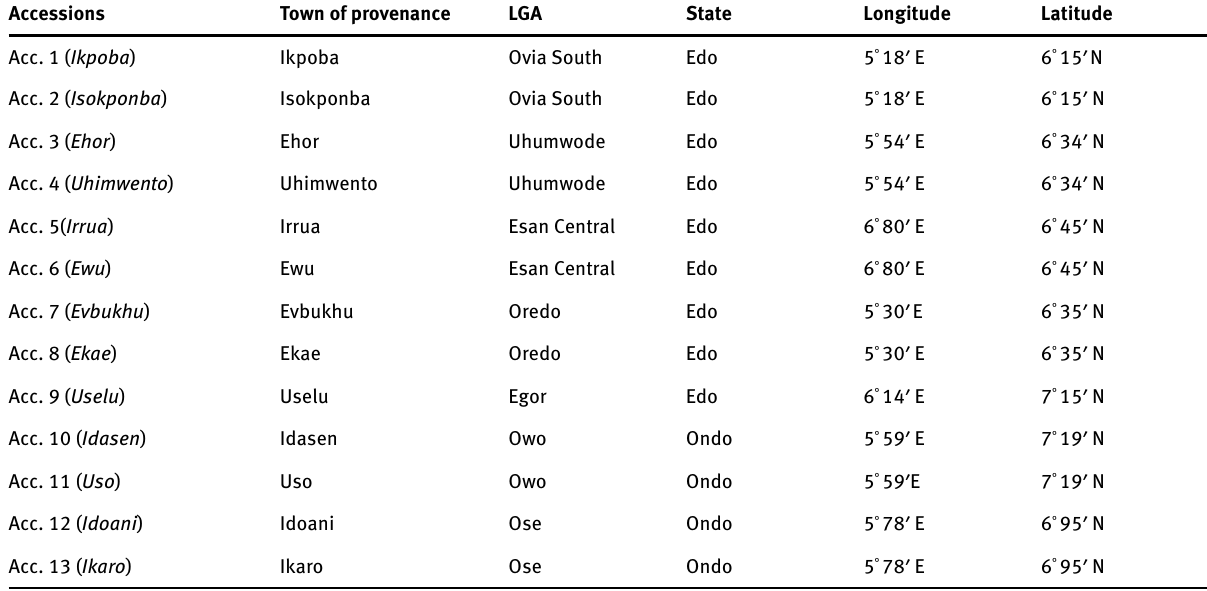
Table 3: Thirteen (13) tannia accessions and their geographical origin (community and geographical coordinates) of the area